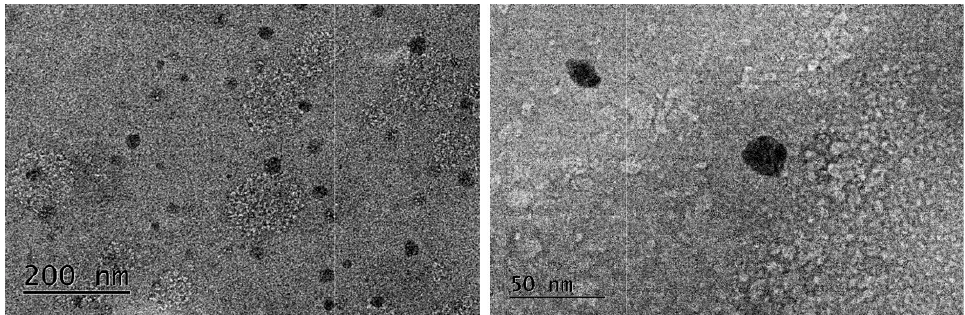
Figure 1. TEM images of chitosan/alginate NPs at different magnifications.